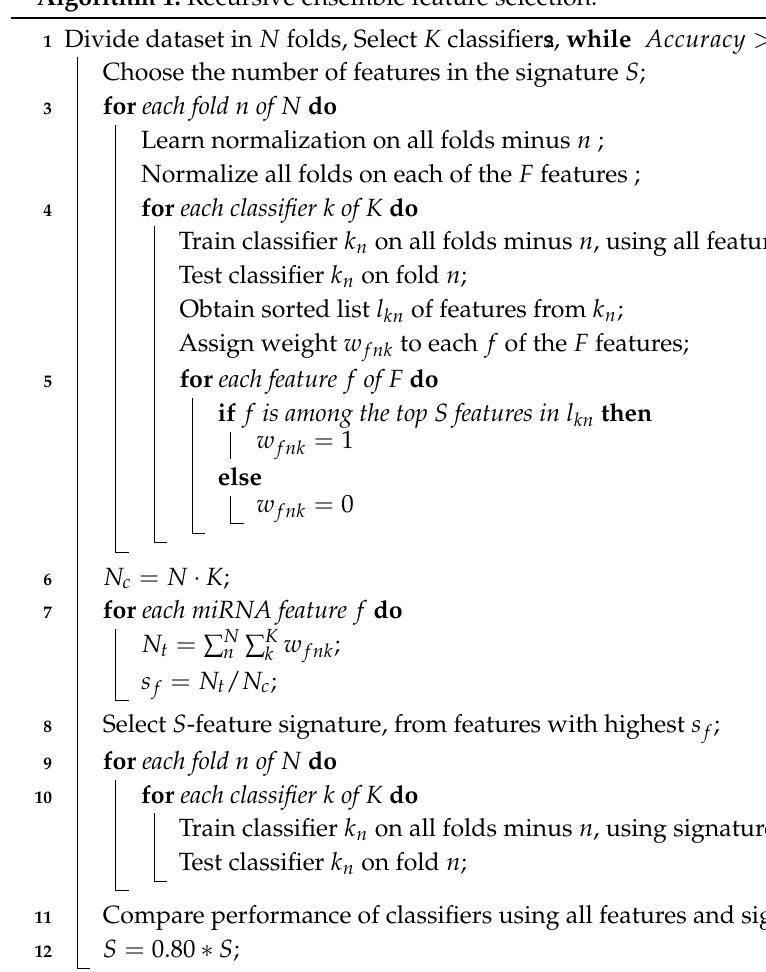
Algorithm 1: Recursive ensemble feature